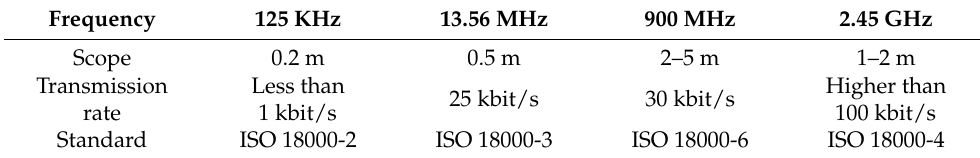
Table 2. Technical